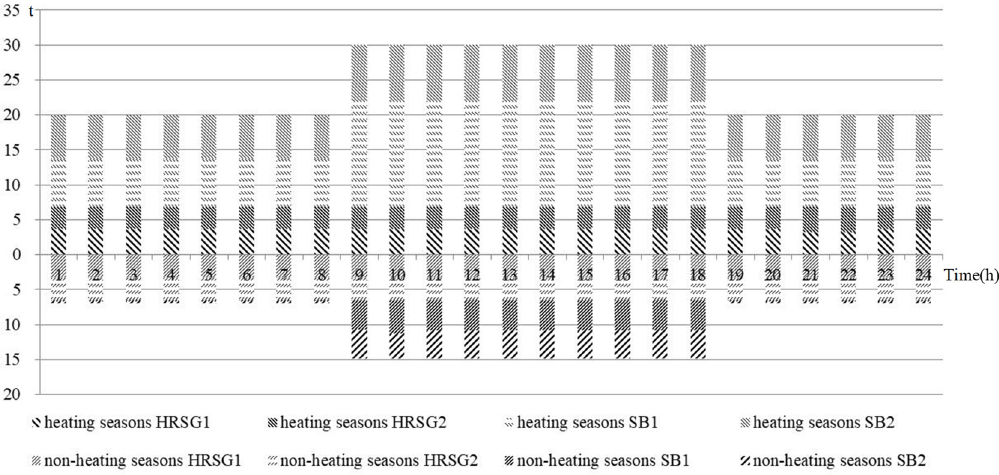
Figure 4. The output of HRSGs and SBs in different periods.